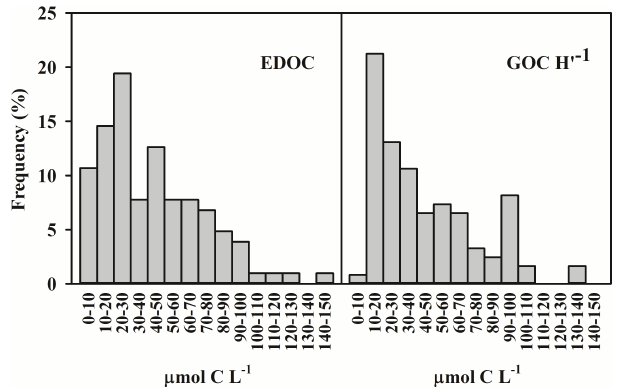
Figure 7. Frequency distribution of surface EDOC (median 34µmolCL − 1 ) and GOC H 0− 1 (median 36µmolCL − 1 ) for all three